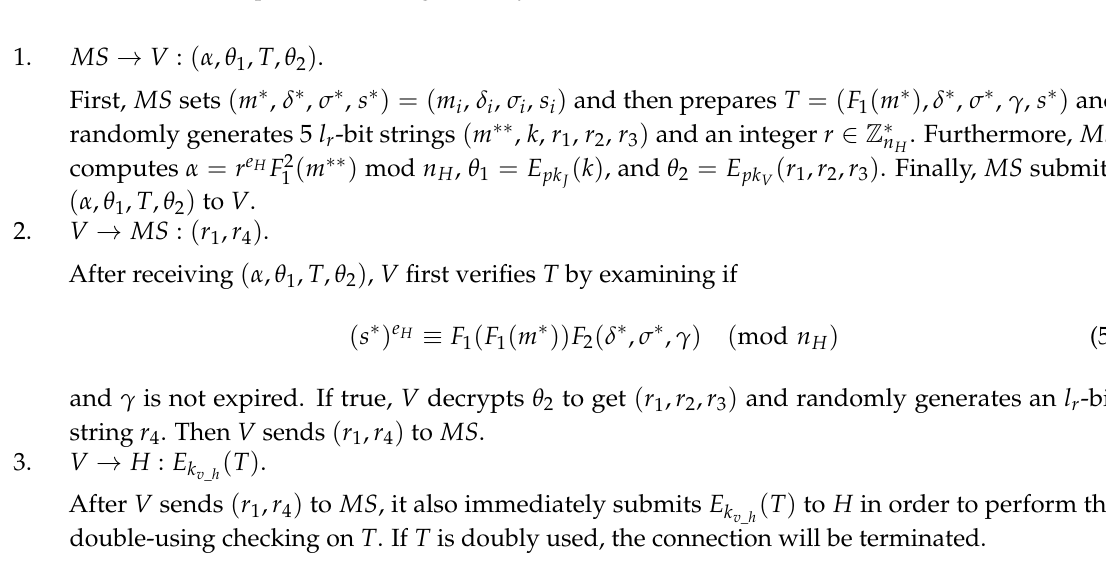
Figure 4. The protocol for using an anonymous ticket in the i -th round before the due